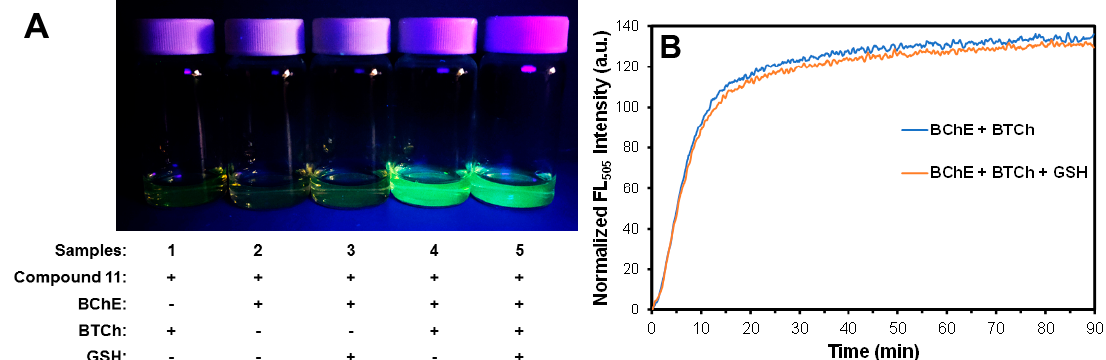
Figure 3. Using the chemical probe 11 for accurate determination of BChE activity in the presence of a physiological concentration of GSH. Each vial contained 25 μ M of 11 in PB and various combinations of BChE (182 U L − 1 ), BTCh (5 mM), or GSH (50 μ M). The reactions were carried out at rt or 37 °C for 90 min, and ( A ) was visualized by UV lamp illumination (365 nm) or ( B ) was monitored spectrofluorometrically. In ( B ), the normalized fluorescent (FL) intensity at 505 nm for each result was acquired by subtracting a background FL 505 intensity of 11 from the original FL 505 intensity data.